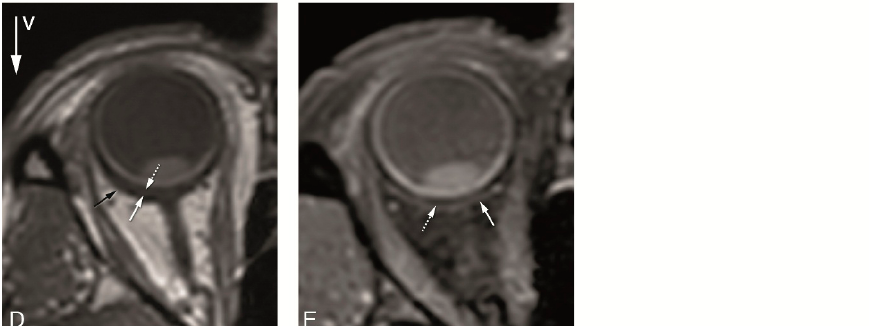
Figure 7. ( A – E ) Water-fat shift artefact and “extra layer” outside sclera. 3D TSE 1 mm T1 ( A ), 3D TSE 1mm enhanced T1 with fat signal suppression ( B ), 3D TSE 0.8 mm T2 with fat signal suppression ( C ), MS 1 mm T1 ( D ) and MS 1 mm enhanced T1 with fat signal suppression ( E ) in the same patient. The water-fat shift artefact is prominent on the MS sequence ( D ) (black arrow), seen as a signal void crescent area at the sclera-orbital fat interface, occurring in the frequency-encoding direction and therefore behind the sclera. It is important to be acquainted with this artefact not to misinterpret it as sclera which would overestimate the sclera thickness. The water-fat shift artefact is negligible on the 3D TSE sequence ( A ) and it is not present on the sequences with fat suppression ( B , C , E ). Notice, especially on the sequences with fat signal suppression ( B , C , E ), but also visible on the MS 1 mm T1 ( D ), the presence of a thin layer slight hyperintense on T1 and T2 (arrows), perhaps corresponding to the Tenon’s space or to a slight layer of fluid outside the globe, allowing a good identification of the outer limit of the sclera (dashed arrows).